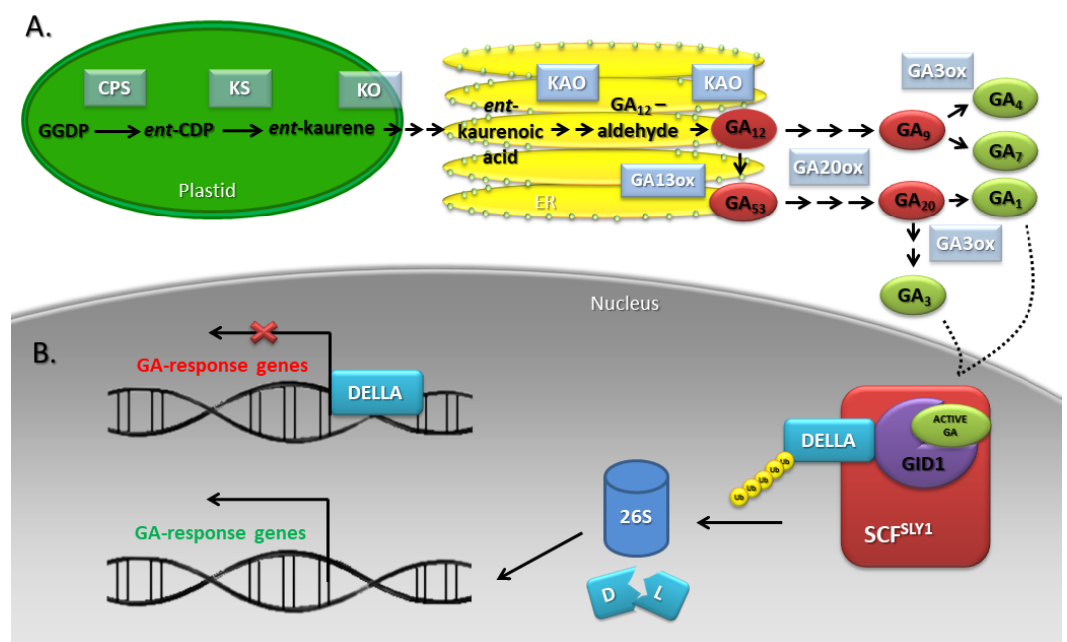
Figure 4. GA biosynthesis (A) and signaling (B) pathways in A. thaliana . GAs are synthesized